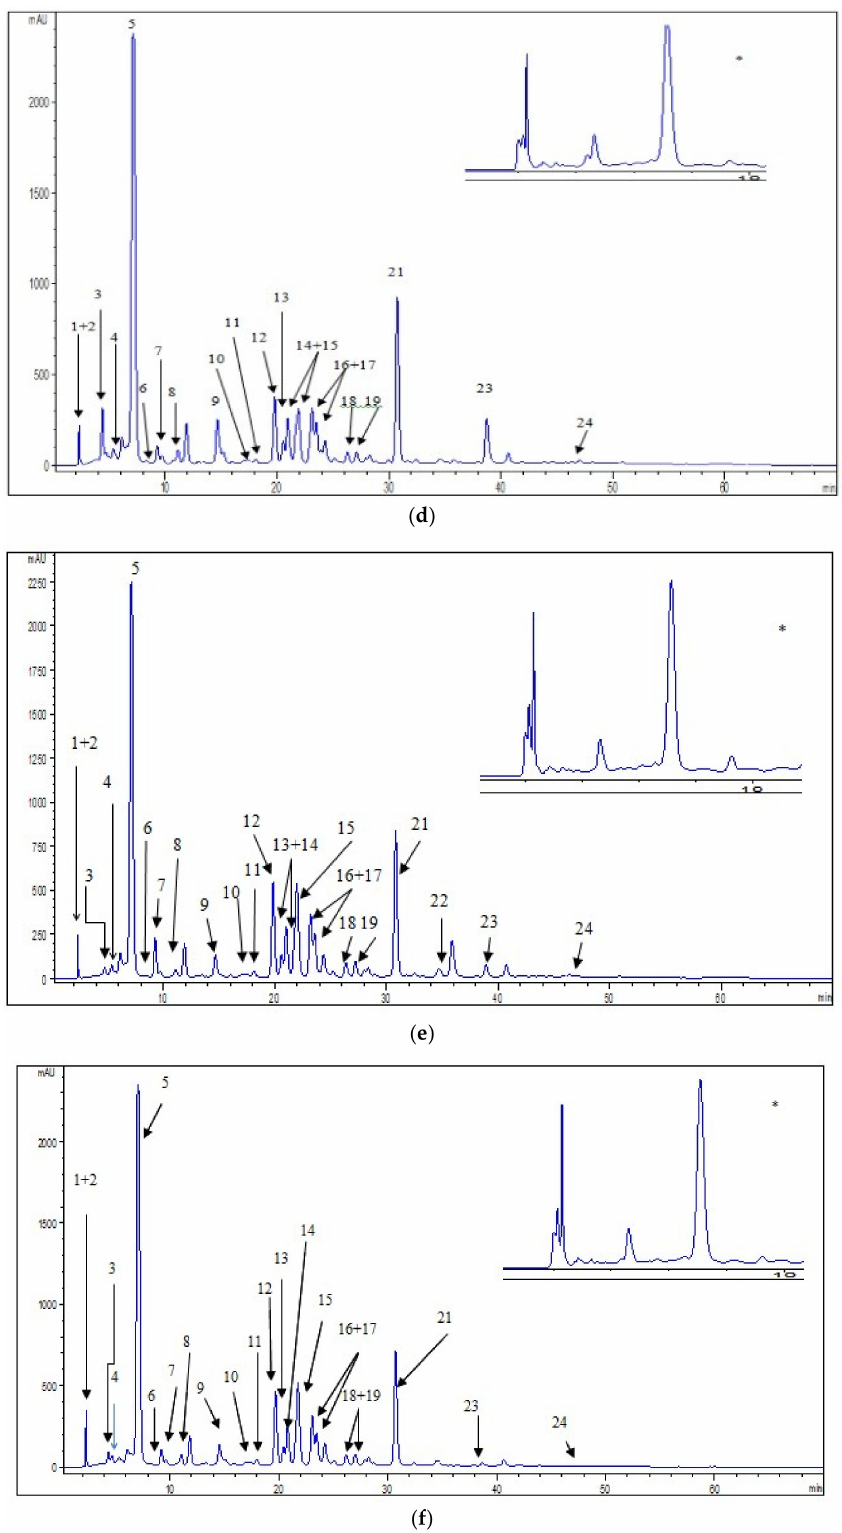
Figure 3. HPLC chromatograms of investigated extracts and phenolic compound identified at 325 nm in: ( a ) MFES; ( b ) MFEM; ( c ) MFEI; ( d ) MLES; ( e ) MLEM; ( f ) MLEI. (* Separation of gallic acid and pyrogallol was also presented at 260 nm in MLES, MLEM and